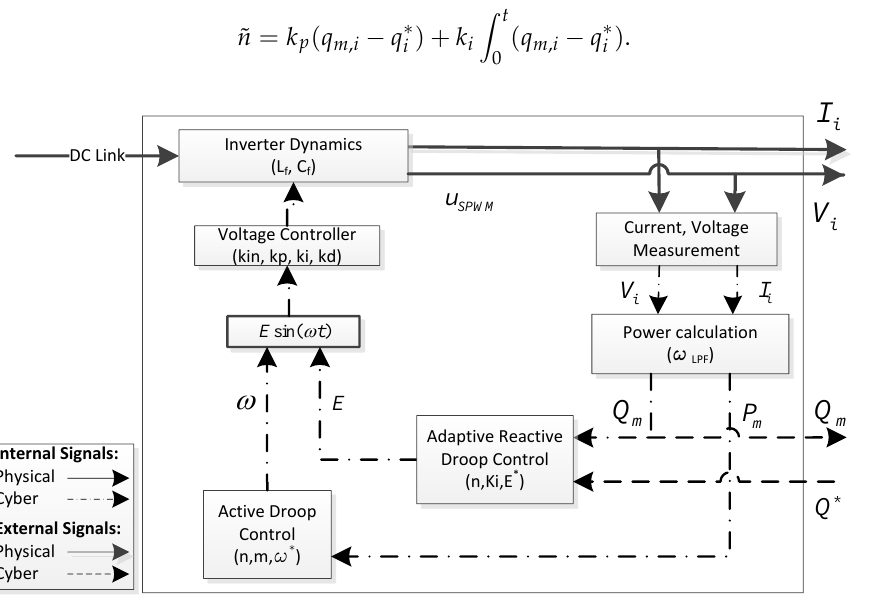
Figure 5. IDG CPES module (adaptive droop